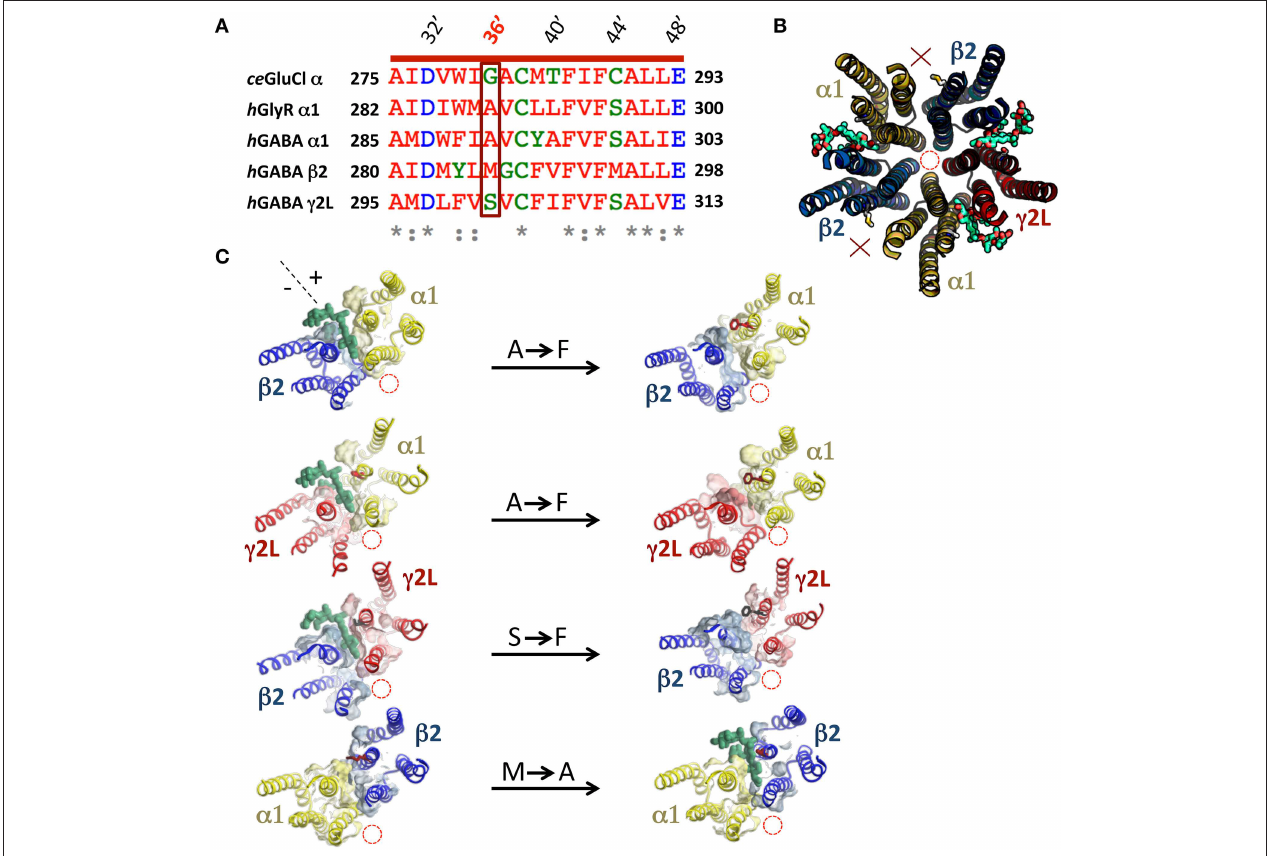
FIGURE 2 | Molecular modeling of ivermectin binding to its subunit interface binding sites in the α 1 β 2 γ 2L GABA A R. (A) Amino acid sequence alignment of M3 residues of the human α 1, β 2, and γ 2L GABA A R subunits, the human α 1 GlyR subunit and the C. elegans α GluClR subunit with their respective 36 ′ residues highlighted in a box. (B) Molecular structural model of the transmembrane domains of a wild type β 2- α 1- β 2- α 1- γ 2L GABA A Rviewed from the extracellular side of the membrane along the pore axis. This receptor accommodates three ivermectin molecules (green) in their subunit interface binding sites. In this and subsequent model structures, the pore location is denoted by the red dashed circle, 36 ′ sidechains and bound ivermectin molecules (green) are shown in stick form and interfaces that do not bind ivermectin are indicated by a red X. (C) This panel shows the effect of mutagenesis on the ability of ivermectin to bind at individual interfaces. The left column displays single subunit interfaces formed from (top to bottom) α 1- β 2, α 1- γ 2L, γ 2L- β 2, and β 2- α 1 interfaces, with ivermectin docked where possible. The right column shows the same four subunit interfaces incorporating the indicated mutations (A36 ′ F, S36 ′ F, or M36 ′ A).